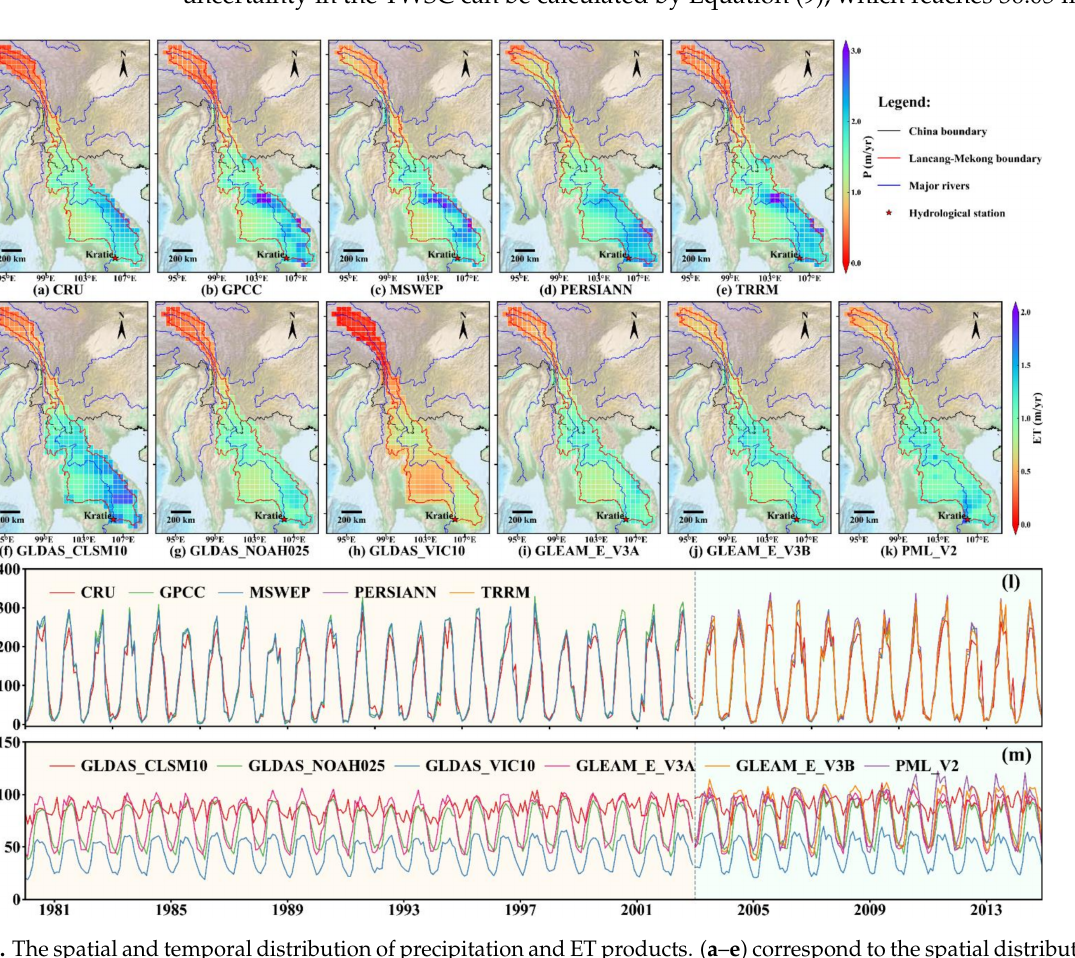
Figure 10. The spatial and temporal distribution of precipitation and ET products. ( a – e ) correspond to the spatial distribution of the CRU, GPCC, MSWEP, PERSIANN, and TRMM precipitation products, respectively; ( f – k ) correspond to the spatial distribution of the GLDAS-CLSM, GLDAS-Noah, GLDAS-VIC, GLEAM-V3A, GLEAM-V3B, and PML-V2 ET products, respectively; ( l ) corresponds to the monthly precipitation time series from ( a – e ); ( m ) corresponds to the monthly ET time series from ( f – k ). Limited by the data availability, only three precipitation products (MSWEP, GPCC, CRU) and four ET products (GLEAM v3.3a, GLDAS NOAH/VIC/CLSM) were used in the water balance method for